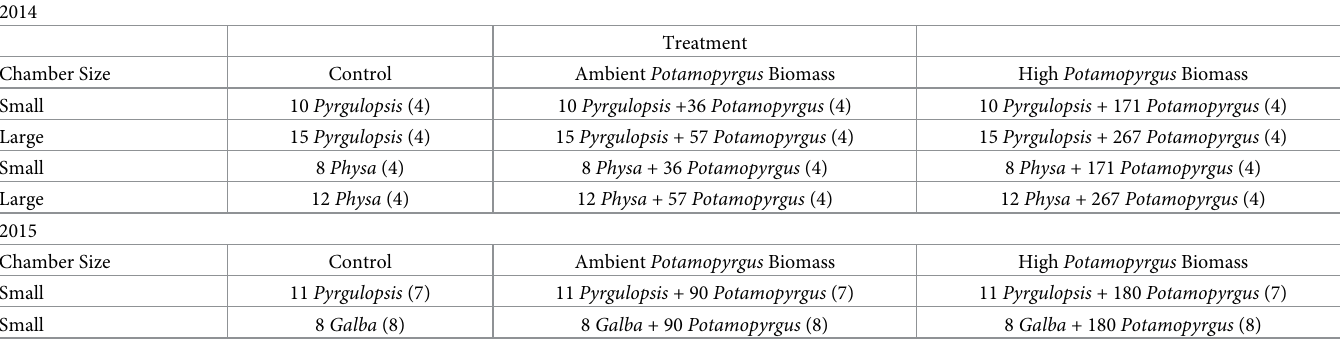
Table 2. Experimental designs for 2014 and 2015. The native species are Pyrgulopsis , Physa , and Galba , and Potamopyrgus is the non-native. The number of individuals of each species in each experimental chamber are noted, and the number of replicates of each treatment are in parentheses. The differences between the experimental designs between the two years were: 1) duration of the experiment in 2014 was 28 days and the duration in 2015 was 12 days, 2) small and large chambers were used in 2014 and only small chambers in 2015, and 3) four replicates per treatment in 2014 and 7–8 in